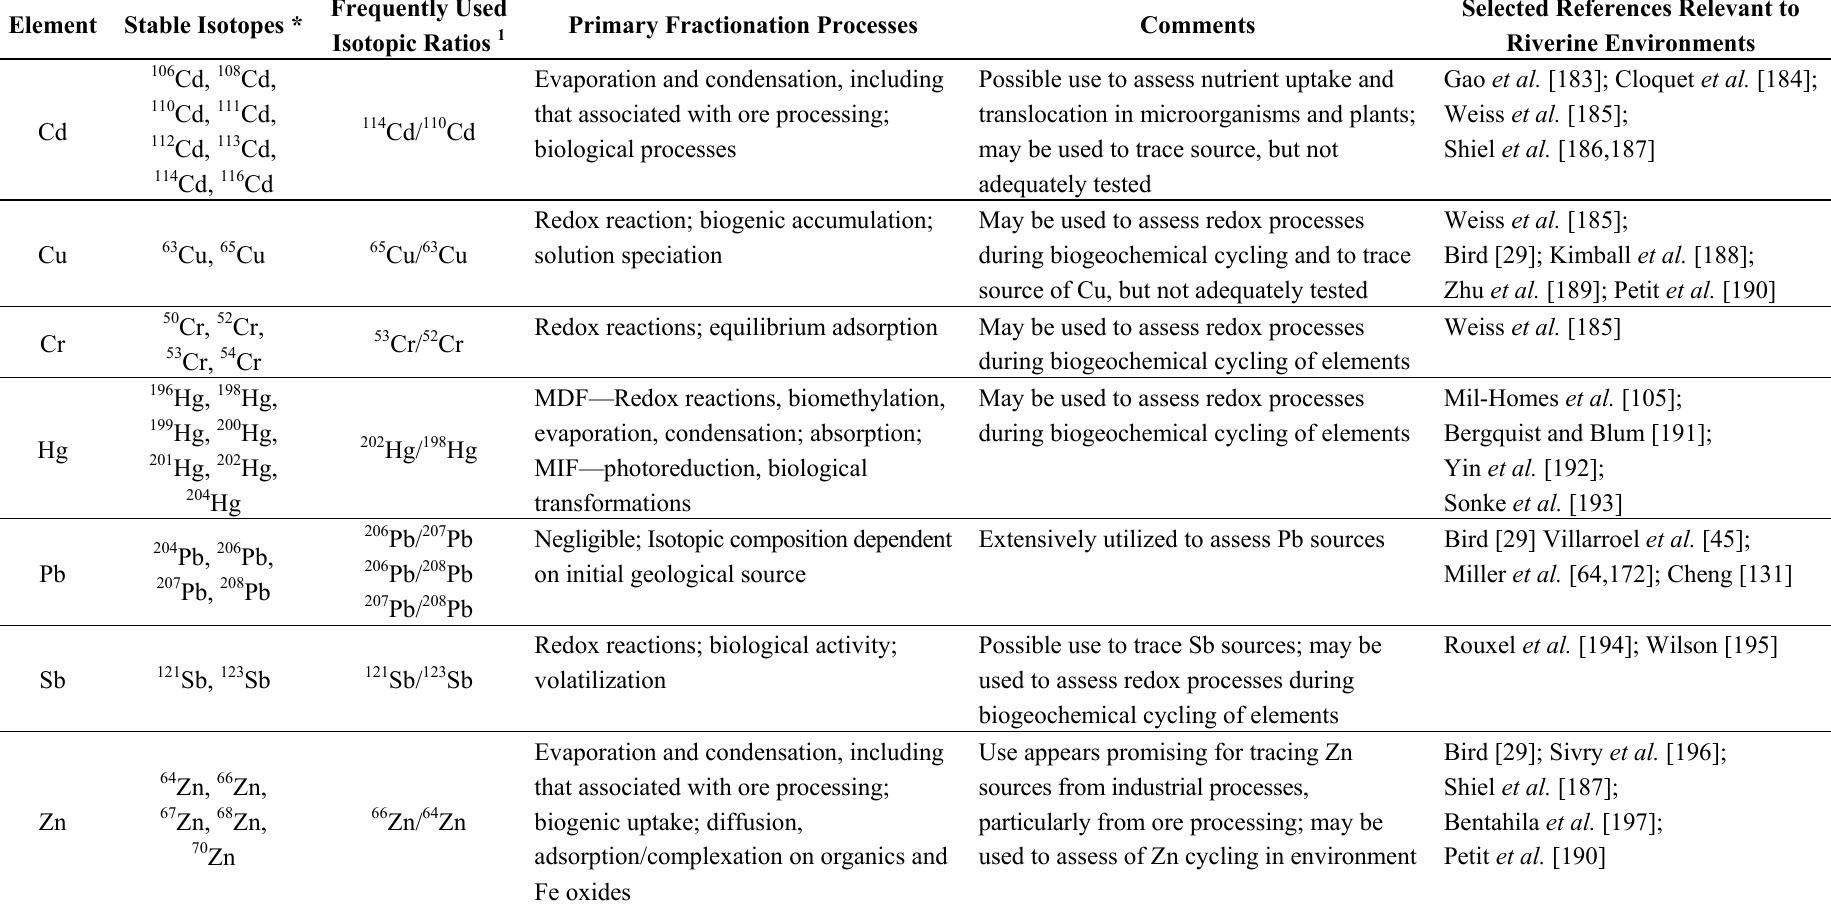
Table 2. Summary of Selected Elemental Isotope Characteristics and Use as a Geochemical Fingerprint and Tracer.